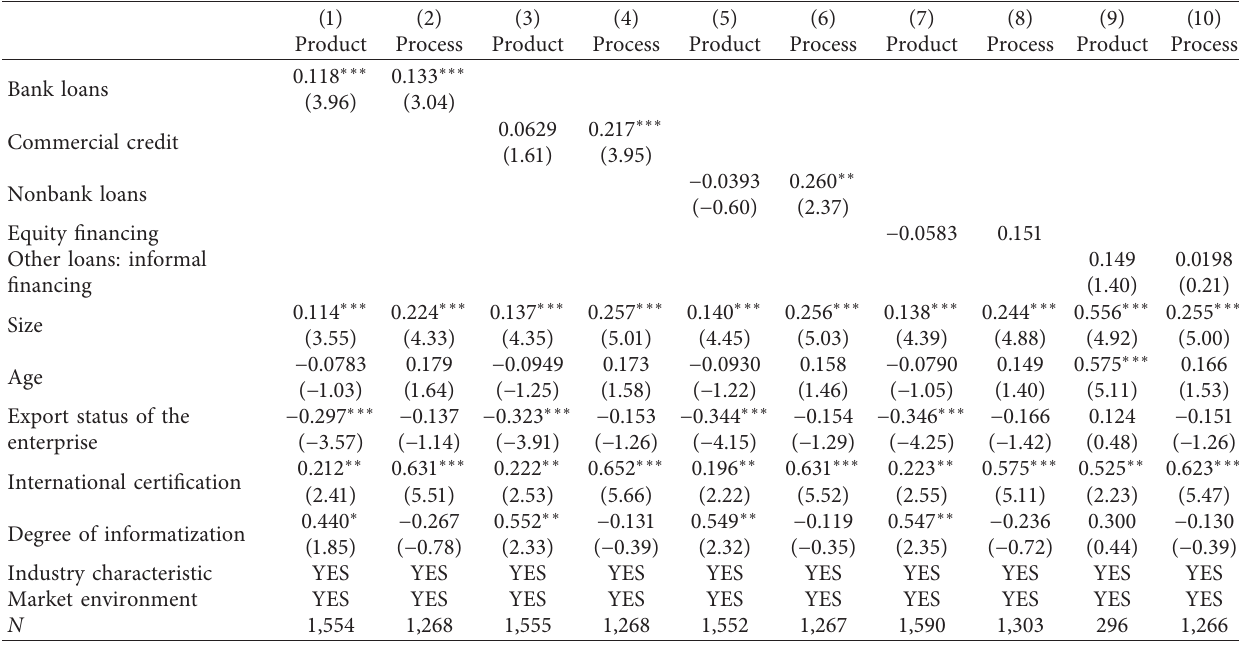
Table 8: External financing method and technological innovation of